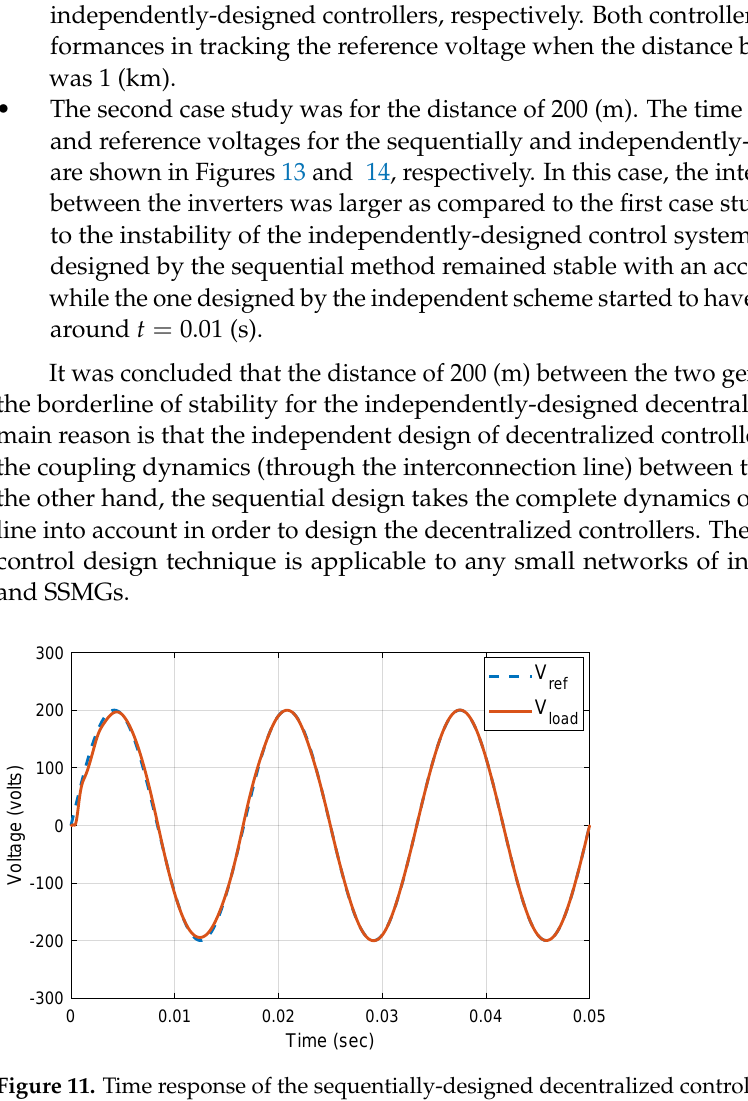
Figure 11. Time response of the sequentially-designed decentralized controllers for 1 (km) distance between the